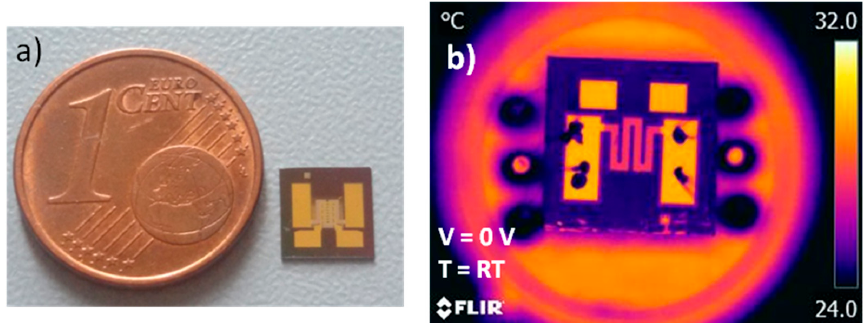
Figure 10. ( a ) Buried micro-hotplate die; ( b ) infrared thermography of the micro-hotplate bonded in TO-8 package.